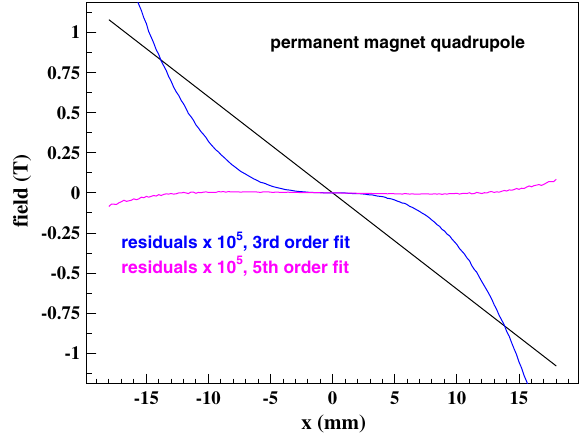
FIG. 3. Distribution of the field component B φ in the midplane of a permanent magnet quadrupole as described in the text. The residuals represent the terms with nonlinear radial dependency in our test